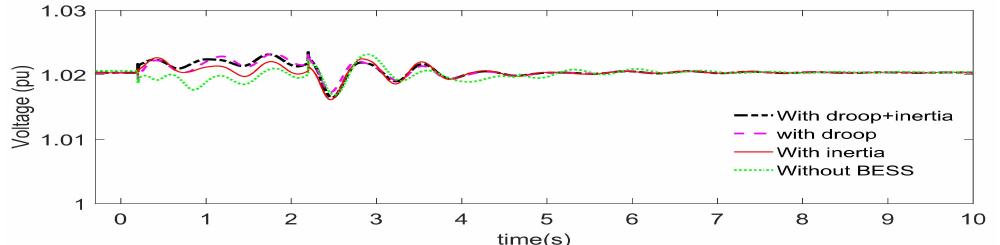
Figure 11. The voltage (pu) at PCC with the generation